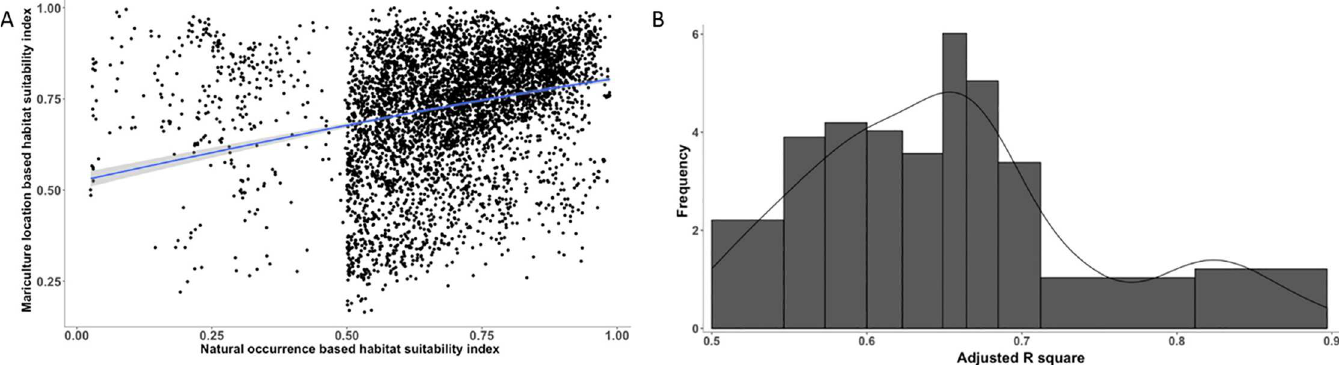
Fig 3. The relationship between predicted mariculture habitat suitability index (HSI) and natural occurrence habitat suitability index. (A) Regression of global predicted mariculture HSI and natural occurrence HSI (p < 0.001). (B) Histogram of adjusted R 2 of individual species’ regression analysis with a mean value of 0.66.